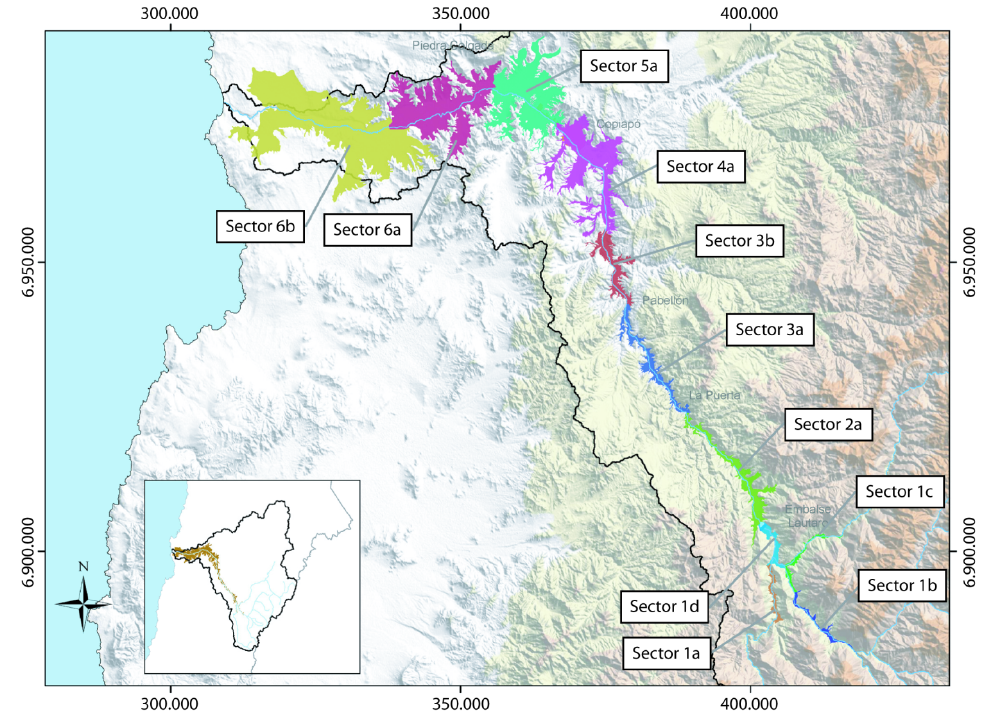
Figure 2. Administrative sectors (1 through 6) in the aquifer of the Copiapó River